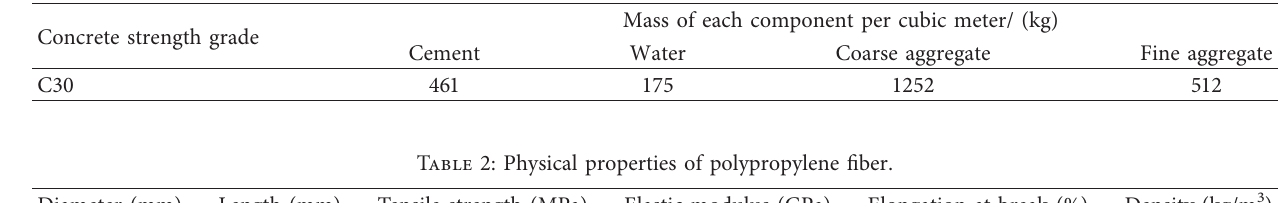
Table 1: Mix proportion (0% fiber) of ordinary concrete.